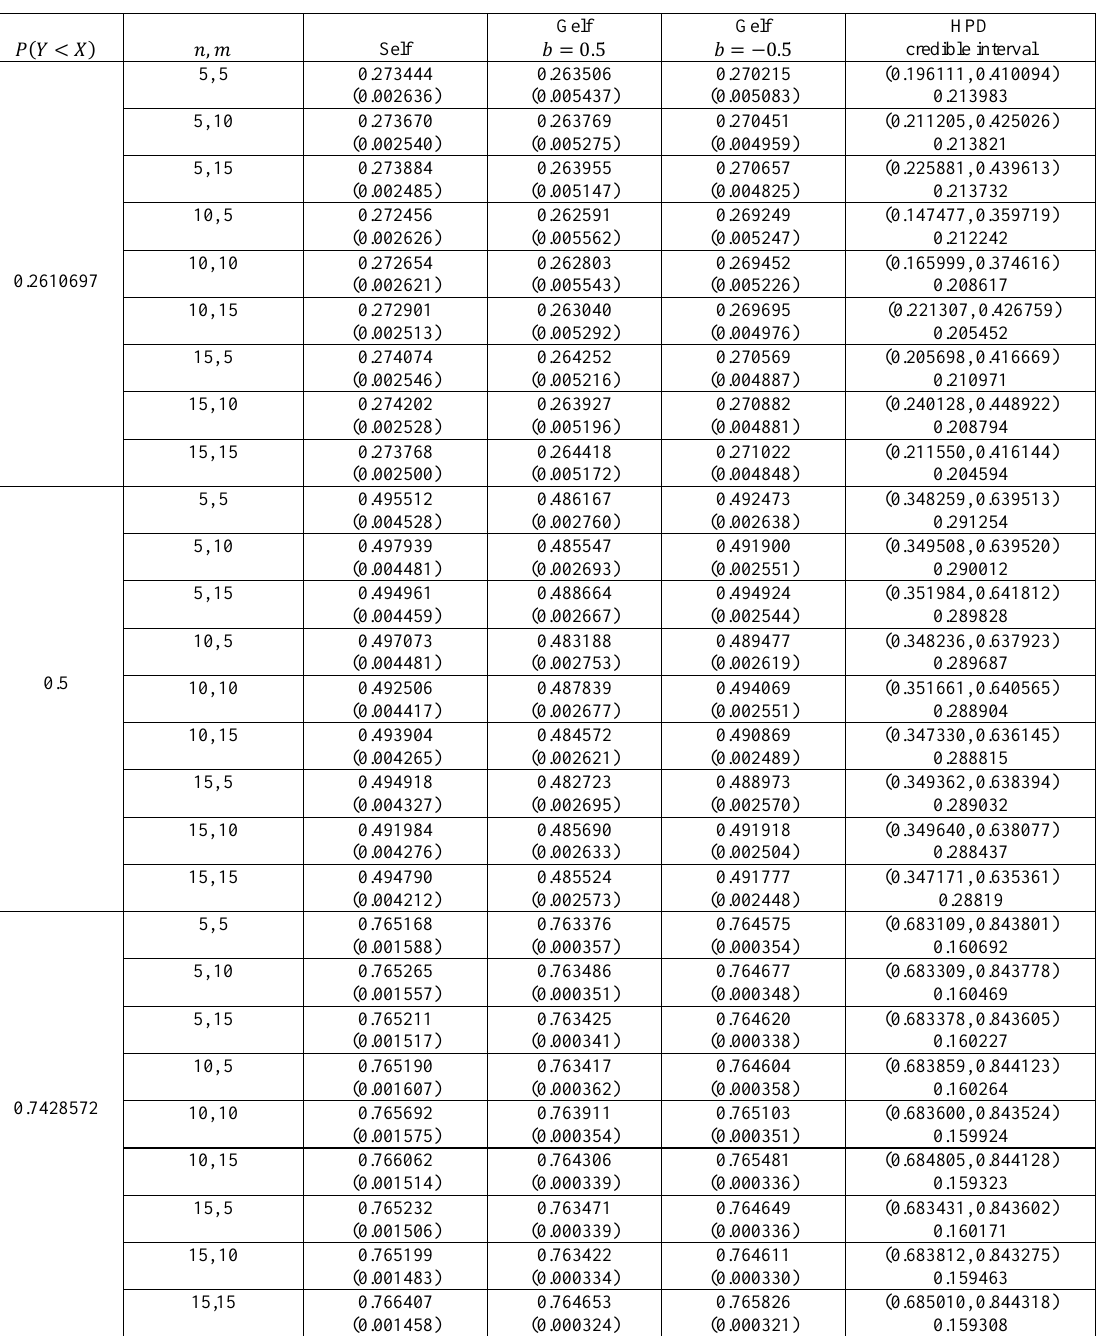
Table 1. Bayes Estimates, Expected loss functions (in brackets), HPD credible intervals (in brackets) with length for 𝜂 = 𝑃(𝑌 < 𝑋) using Gamma prior under squared error loss function (SELF) and